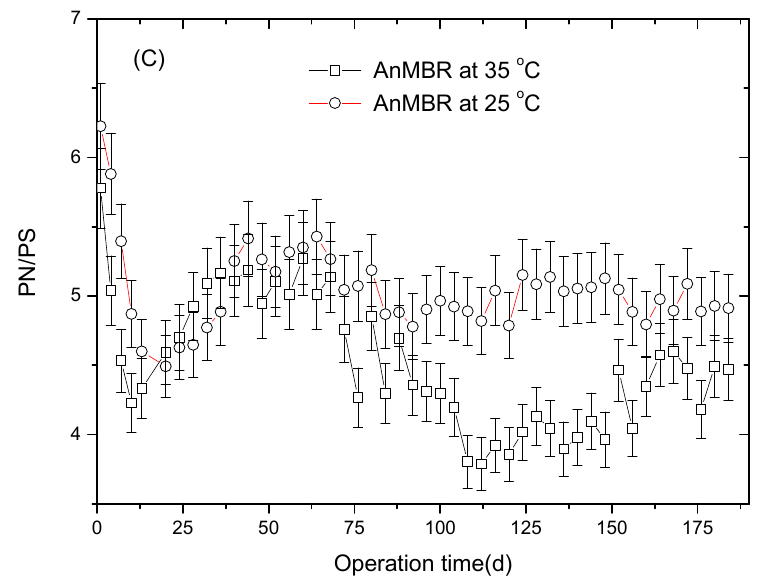
Figure 3. The variations in carbohydrate ( a ) and protein ( b ) contents and the proteins (PN)/polysaccharides (PS) ratio for extracellular polymeric substances (EPS) ( c ) in the two anaerobic membrane bioreactors (AnMBRs) at 35 and 25 °C against the operation time.